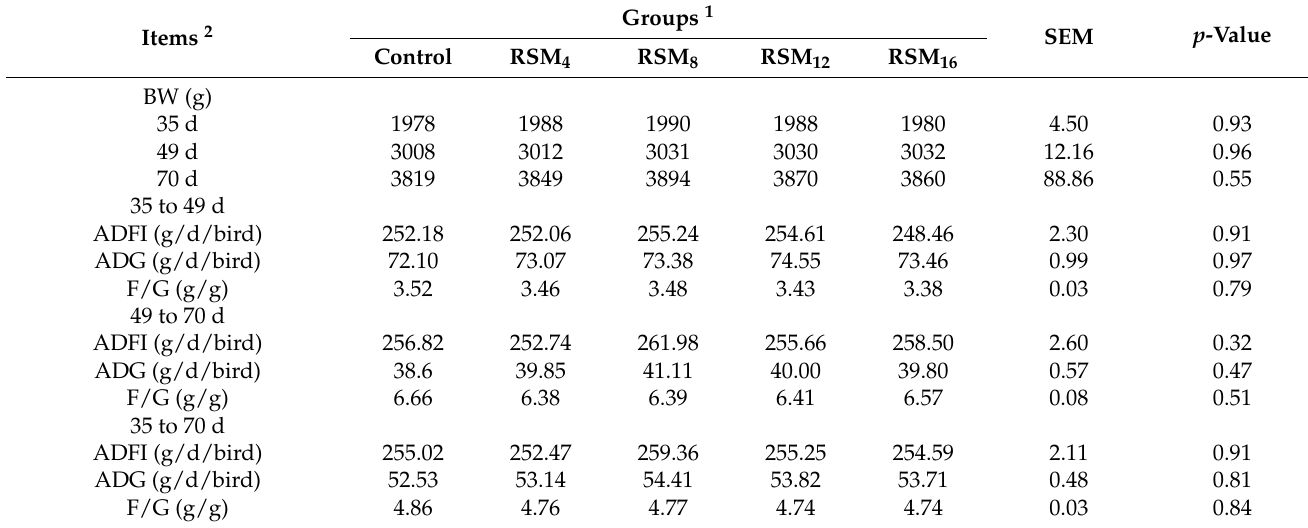
Table 3. Effects of increasing dietary levels of rapeseed meal on the body weight (BW), average daily feed intake (ADFI), average daily gain (ADG), and feed/gain ratio (F/G) of